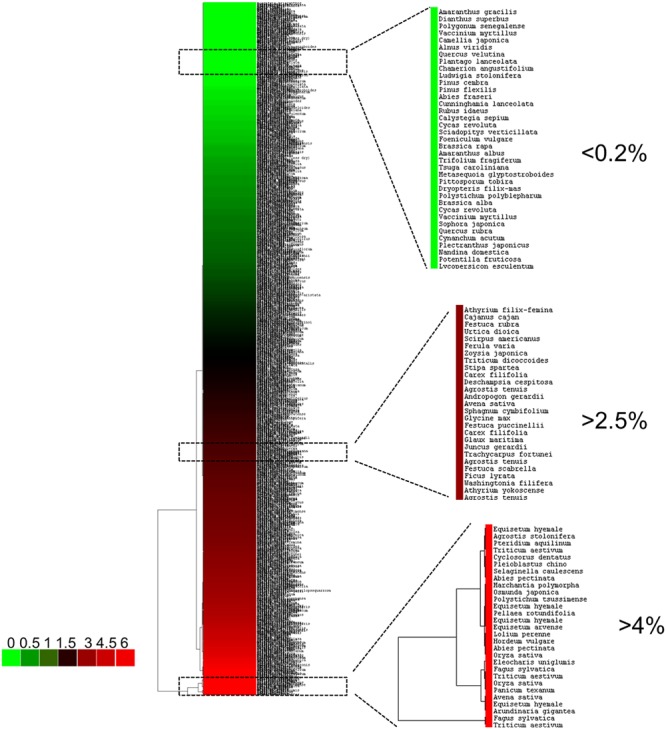
Hierarchical clustering of representative land plants based on their SiO2 content. The data used correspond to those published by Trembath-Reichert et al., 2015 (Dataset S1 of this publication). The hierarchical clustering (Euclidean distance, complete linkage) was performed with Cluster 3.0 (Eisen et al., 1998) and visualized with Java TreeView (Saldanha, 2004). The colorbar indicates the SiO2 content (% wt). The boxed regions of the tree correspond to representatives belonging to different Si-classes.